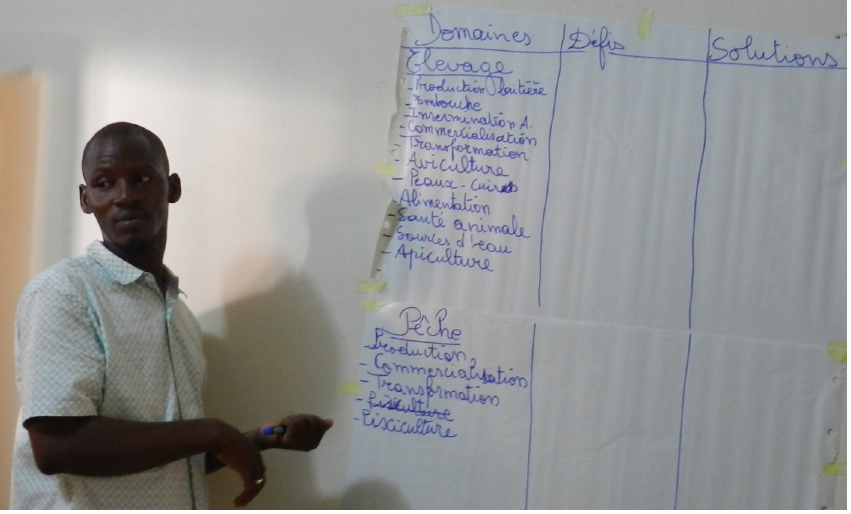
Figure 3. First assessment of domains, challenges and possible solutions done by farmers in Bamako, Mali, October